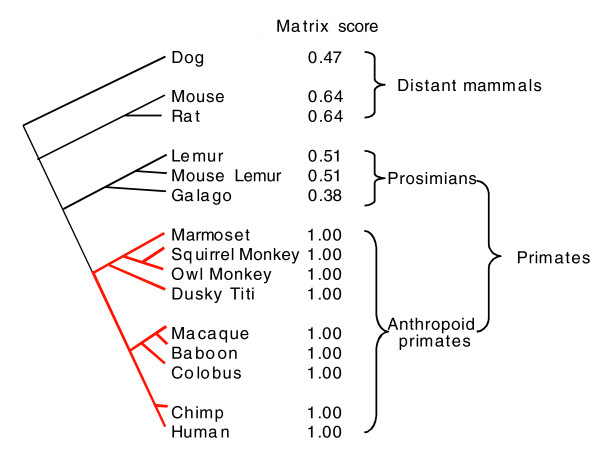
Phylogenetic analysis of the SRE. The human sterol regulatory element (SRE) motif and its orthologs were scored for transcription factor binding affinity, with low motif scores indicating low predicted affinity to SRE binding protein (SREBP; see Materials and methods). Because the SRE is present in all the analyzed anthropoid primates (indicated by the red branches in the tree) and absent from the prosimians, rodents, and dog, emergence in the lineage leading to anthropoid primates is the most parsimonious explanation.